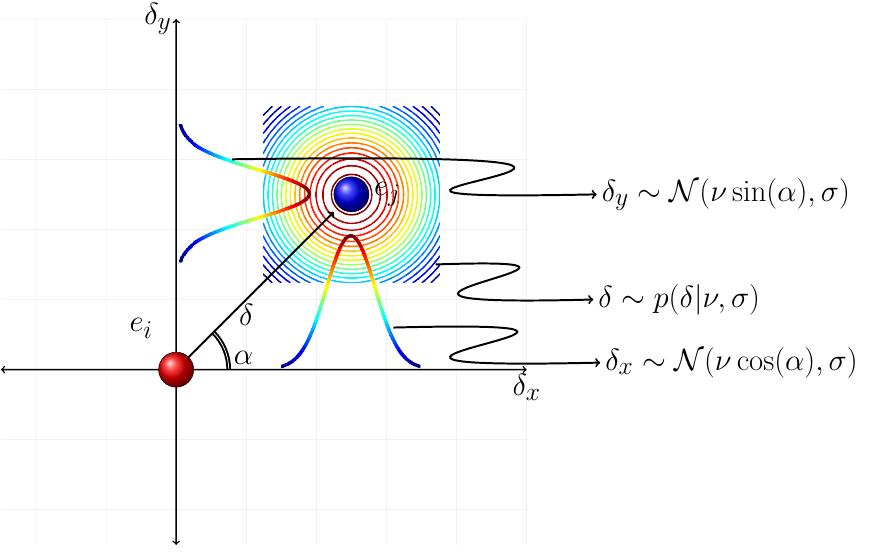
, δ and δ regarding x y